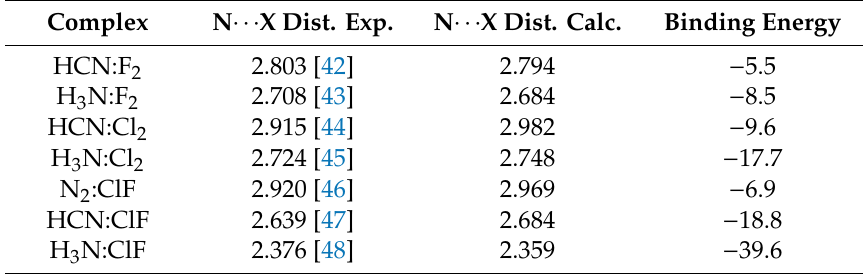
Table 1. Experimental and calculated intermolecular distances ( Å ) and calculated binding energies (kJ mol − 1 ). Complex N · · · X Dist. Exp. N · · · X Dist. Calc. Binding